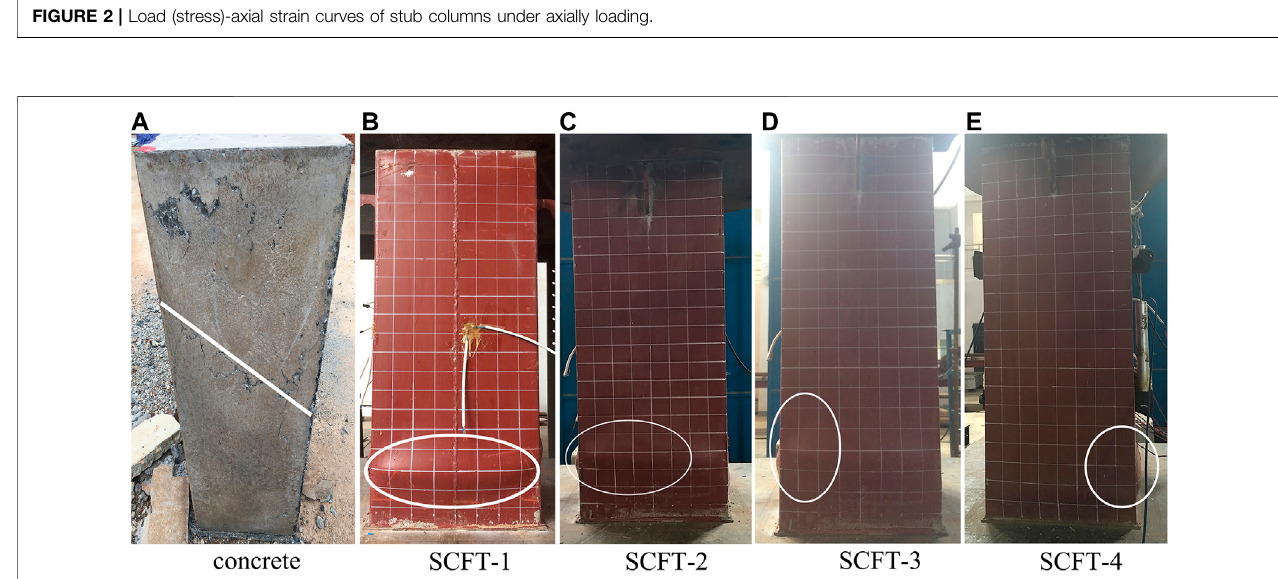
FIGURE 3 | Typical failure modes of